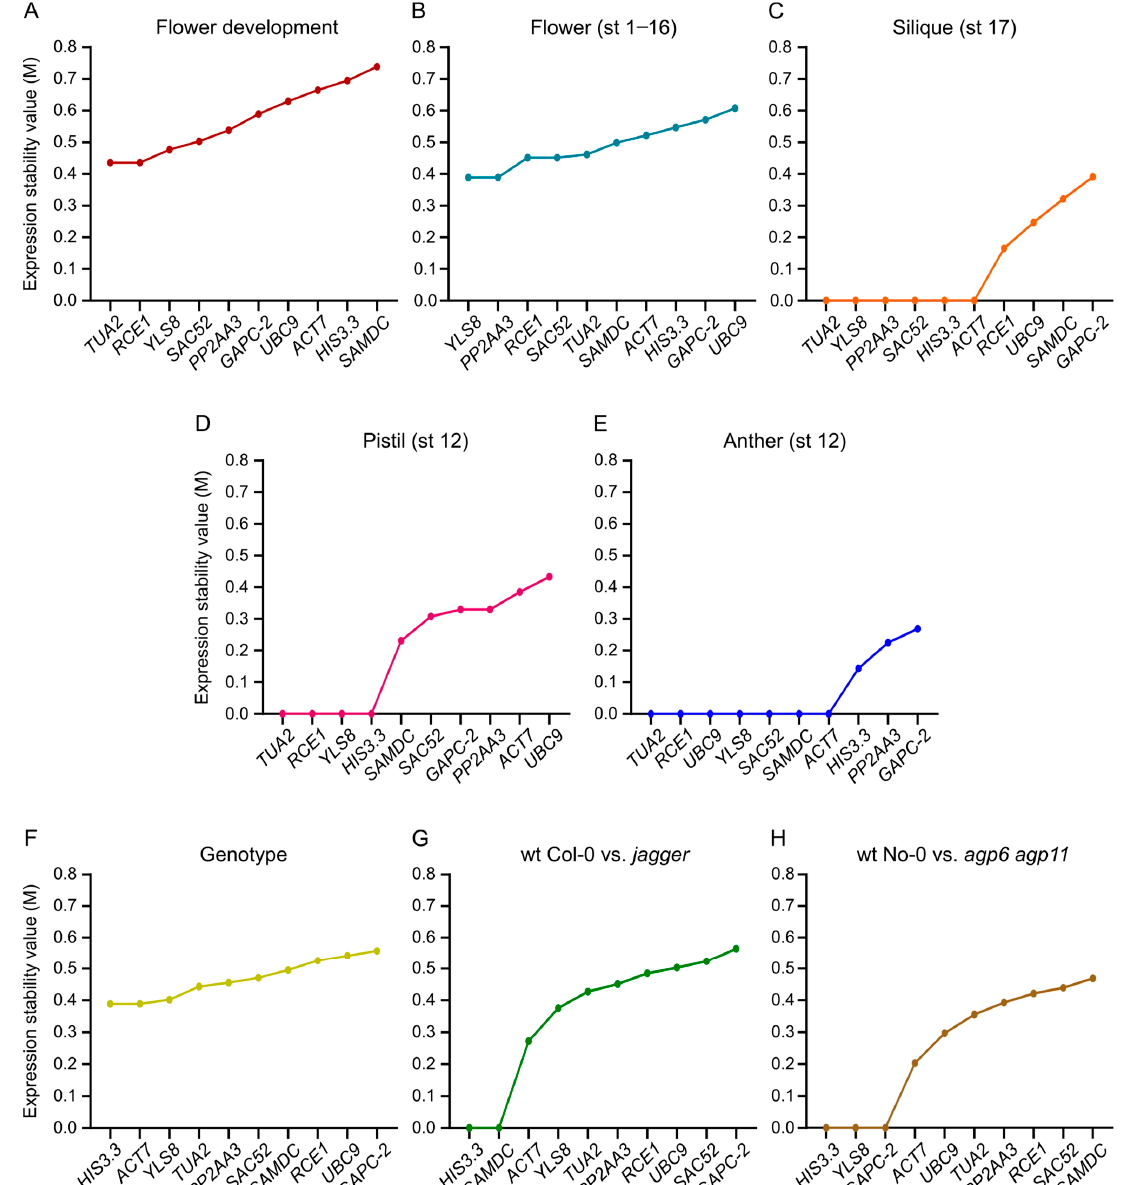
stable is the gene [19]. The ten reference genes across all experimental sets had M values below 0.8, suggesting that these genes were stable across all samples (Figure 2).